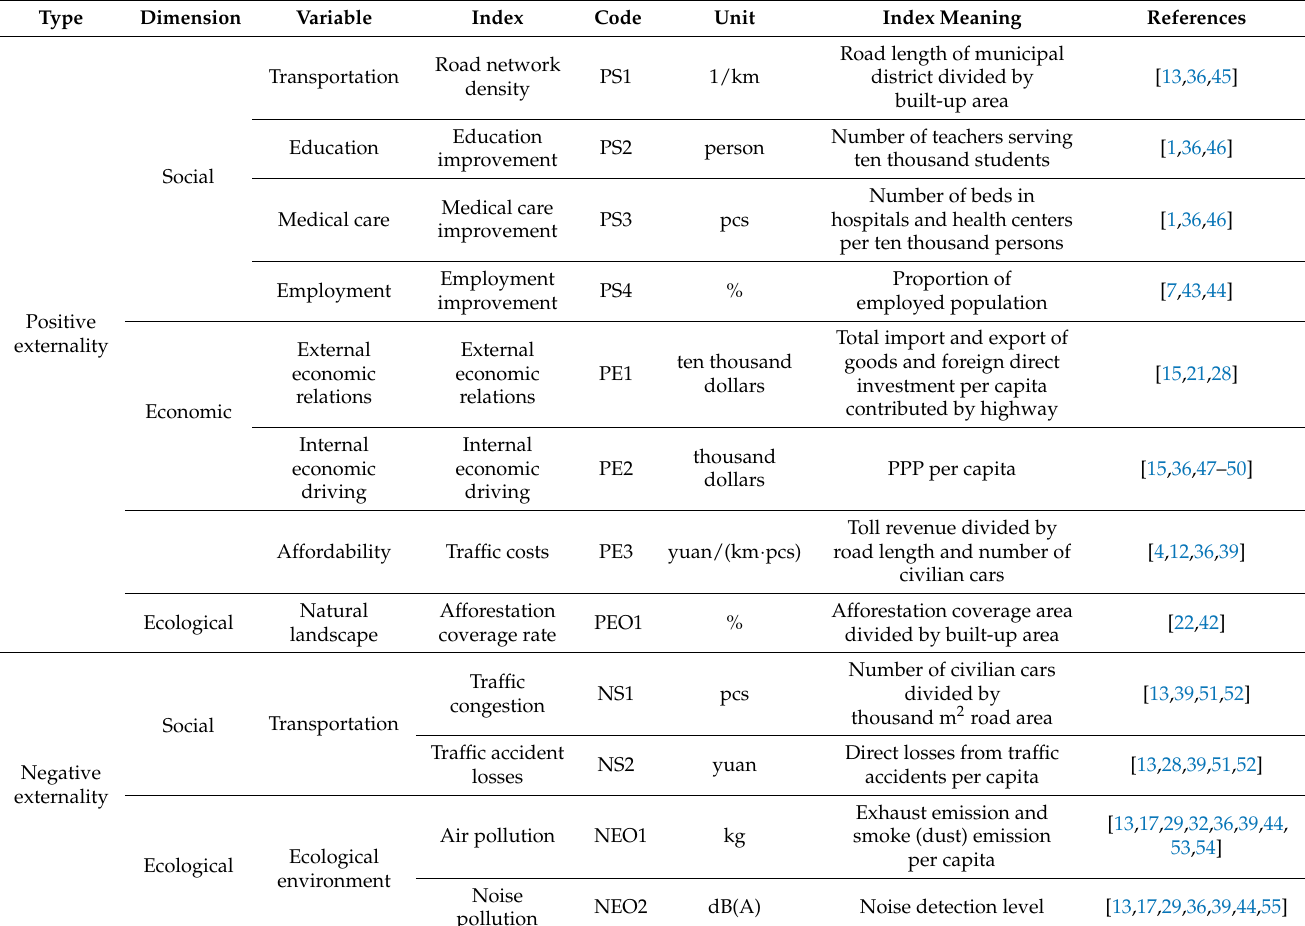
Table 1. Evaluation index system of externalities of highway